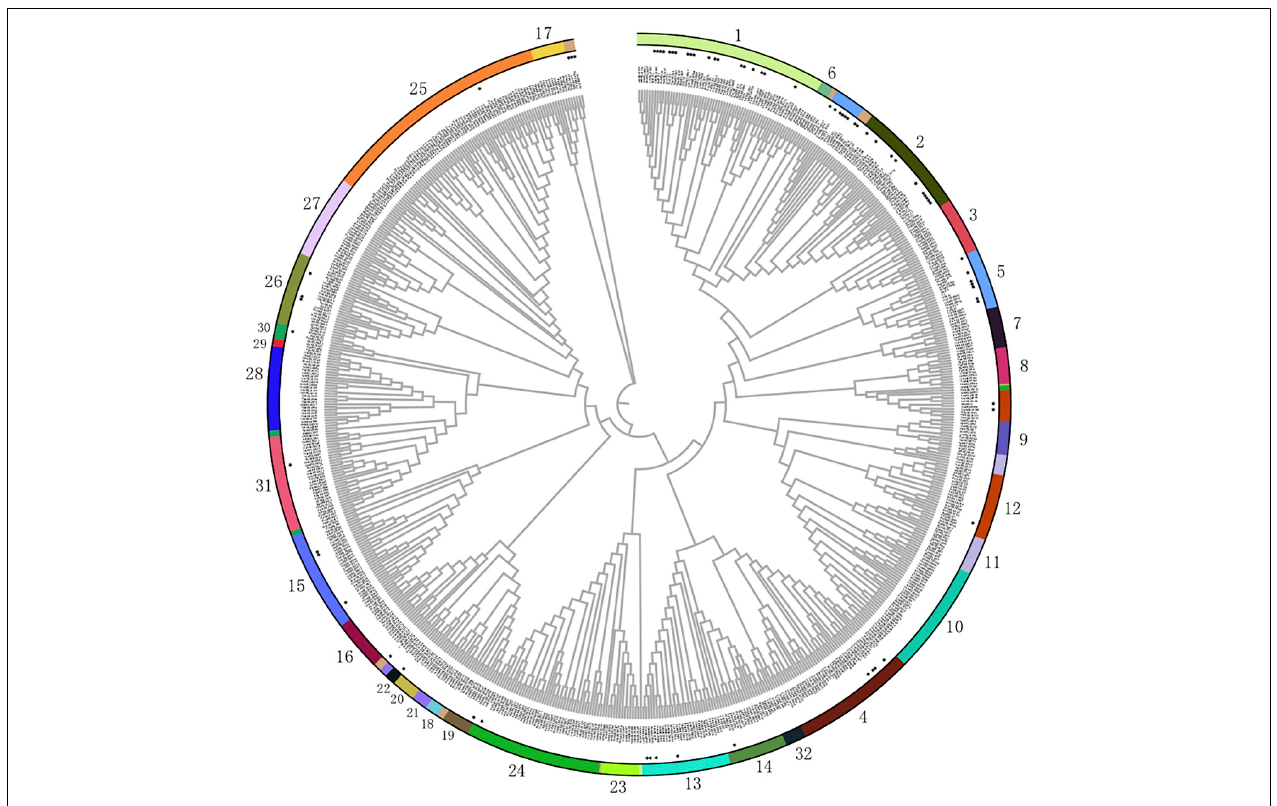
FIGURE 2 | Phylogenetic relationships of bHLH family members. The phylogenetic tree was constructed using MEGA7.0 with the neighbor-joining method and 1000 bootstrap replicates (Huang and Dai, 2015; Wang et al., 2016b). Then the trees were visualized using iTOL (https://itol.embl.de/). Group names were marked outside the circle. The bHLH protein sequences were downloaded from the JGI (http://www.jgi.doe.gov/) and NCBI (https://www.ncbi.nlm.nih.gov) databases. The Gene and Protein IDs of all these bHLHs are list in Supplementary Tables 1 , 2 . And the bHLH members that have been functional annotated are labeled with a star